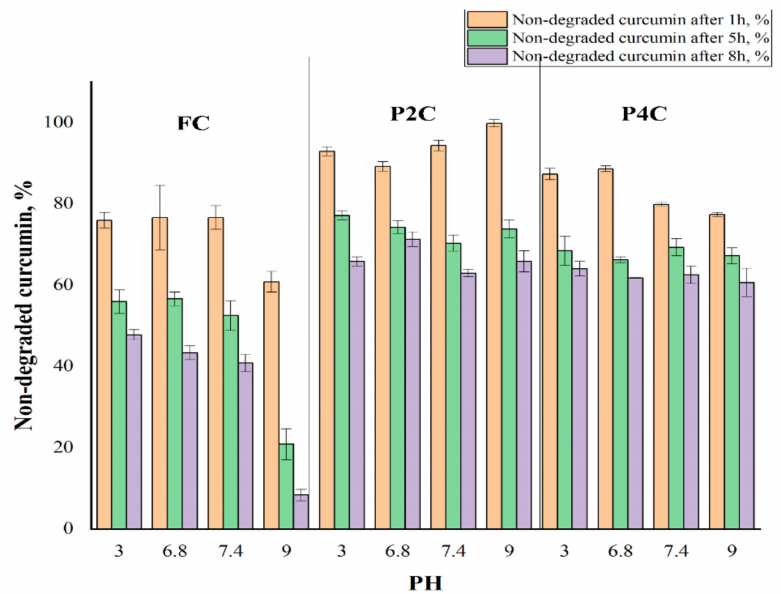
Figure 6. Variation of non-degraded degraded curcumin in time at different pH values for free curcumin (FC) and curcumin immobilized P2C and P4C samples.